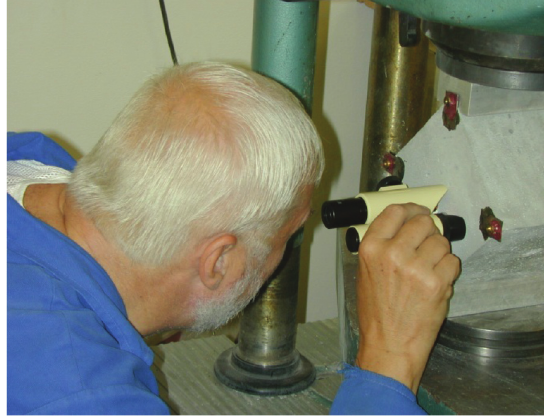
Fig. 5. Suction of air through cracked concrete with Torrent vacuum bell